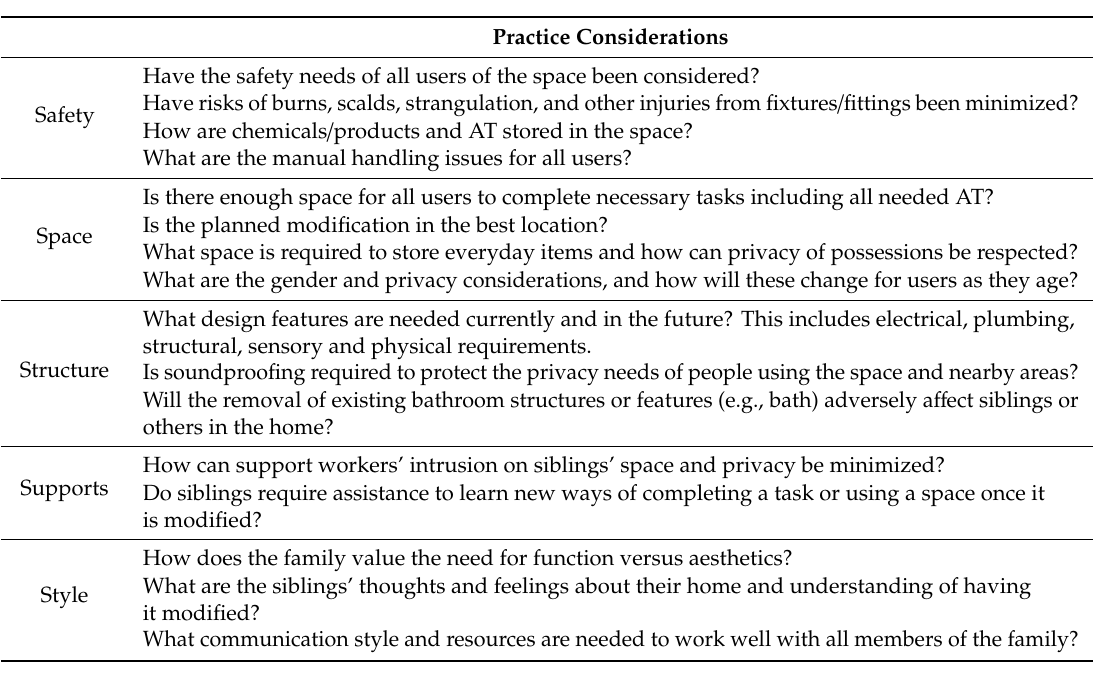
Table 1. Practice considerations for home modifications using the 5 S’s for